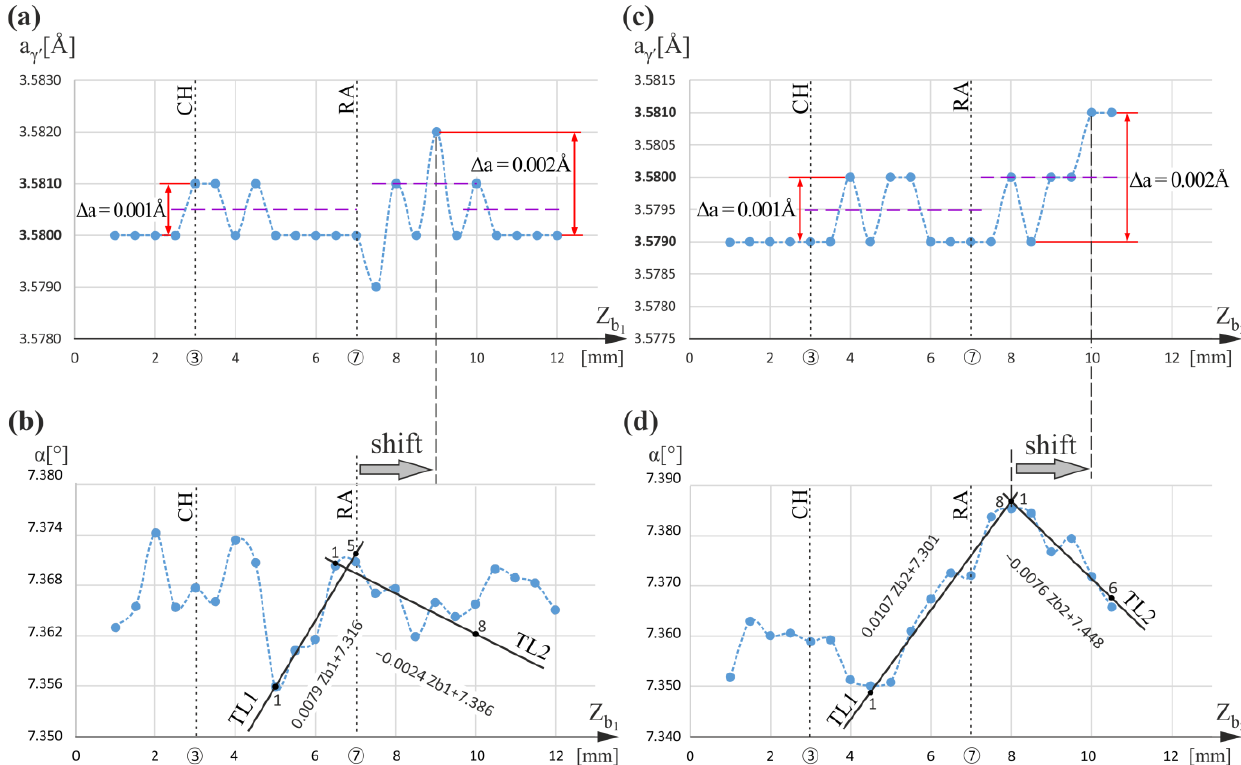
Figure 6. Graphs of the a γ′ (Z b1 ) and α(Z b1 ) relationships obtained for measurement line b 1 ( a , b ); graphs of the a γ′ (Z b2 ) and α(Z b2 ) relationships obtained for measurement line b 2 ( c , d ). Z b1 and Z b2 are parallel to Z.